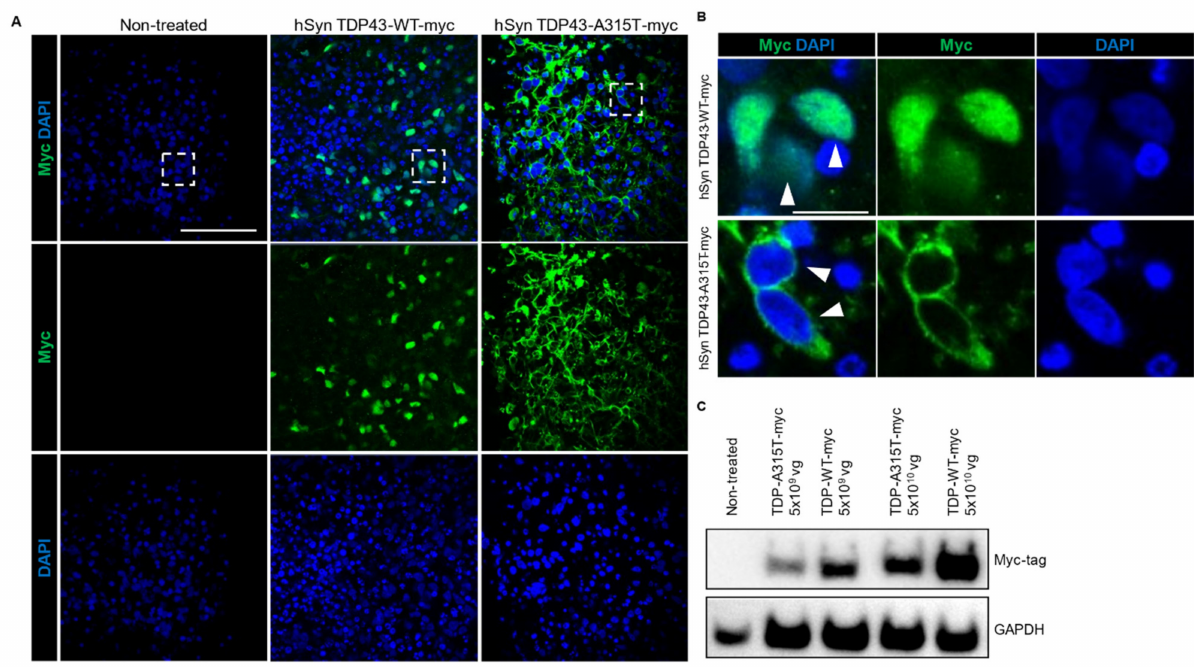
Figure 3. FTD/ALS human cortical organoid model. ( A ) AAV-mediated expression of TDP-43-WT and TDP-43-A315T in human cortical organoids showed widespread expression when immunos- tained with the c-terminal myc tag (green). DAPI stained the nucleus. Scale bar 100 µ m. ( B ) Enlarged images of boxed area in ( A ) showed nuclear localisation of TDP-43 (myc-tagged; green; closed arrowheads) in TDP-43 WT cortical organoids while the TDP-43 in TDP-43 A315T organoids were localised to the cytoplasm (open arrowheads). Scale bar 20 µ m. ( C ) Confirmation of AAV-mediated expression of TDP-43 in TDP-43-WT and TDP-43-A315T cortical organoids via western blotting with myc antibody. 2 different titers of AAV were used (5 × 10 9 vg and 5 × 10 10 vg). GAPDH is used as a loading